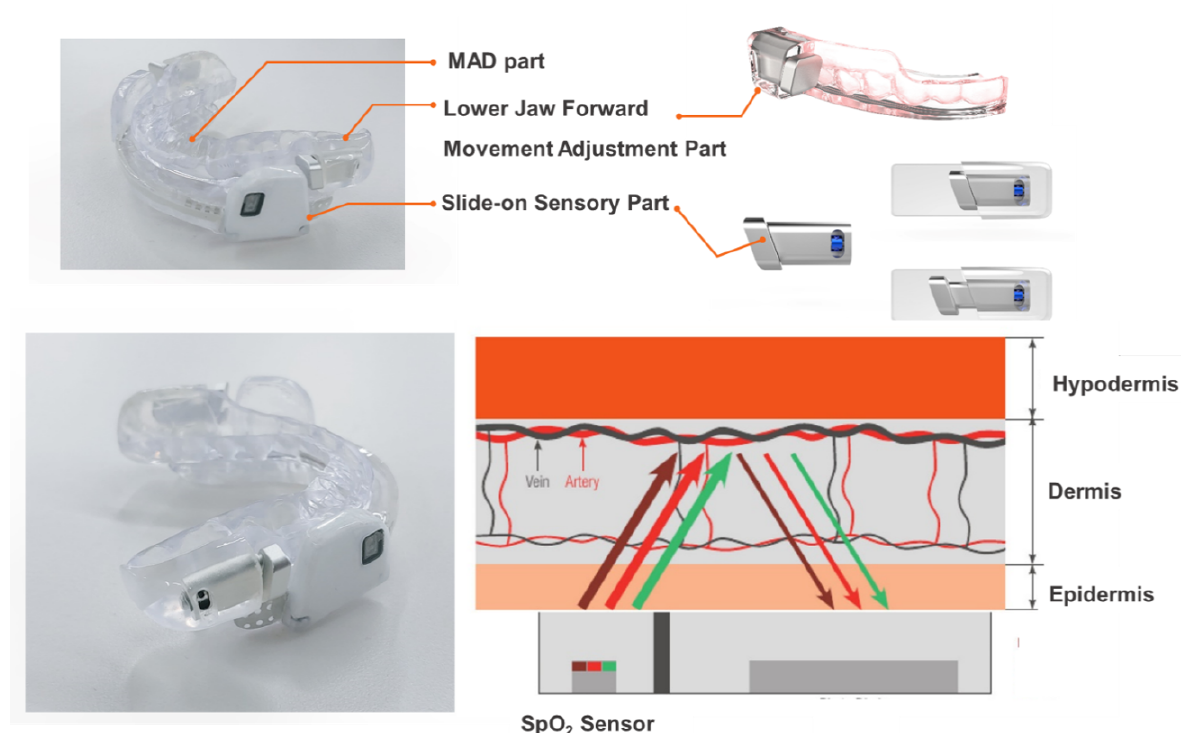
Figure 5. Actually manufactured slide-on prototype model of s-Guard.